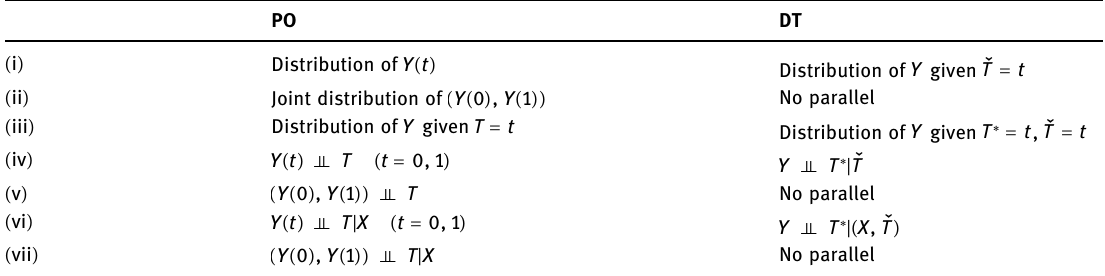
Table 1: Comparison of PO and DT